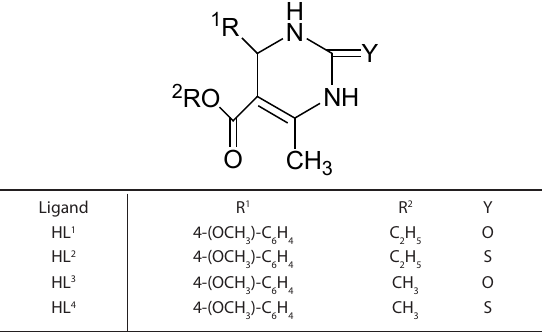
Figure 1. The general structure of the